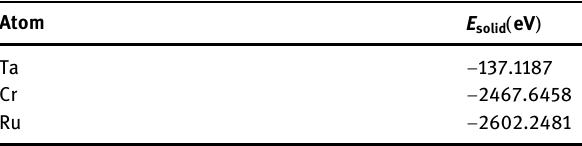
Table 2: Ground state and freedom energy for Ta, Cr, and Ru atoms